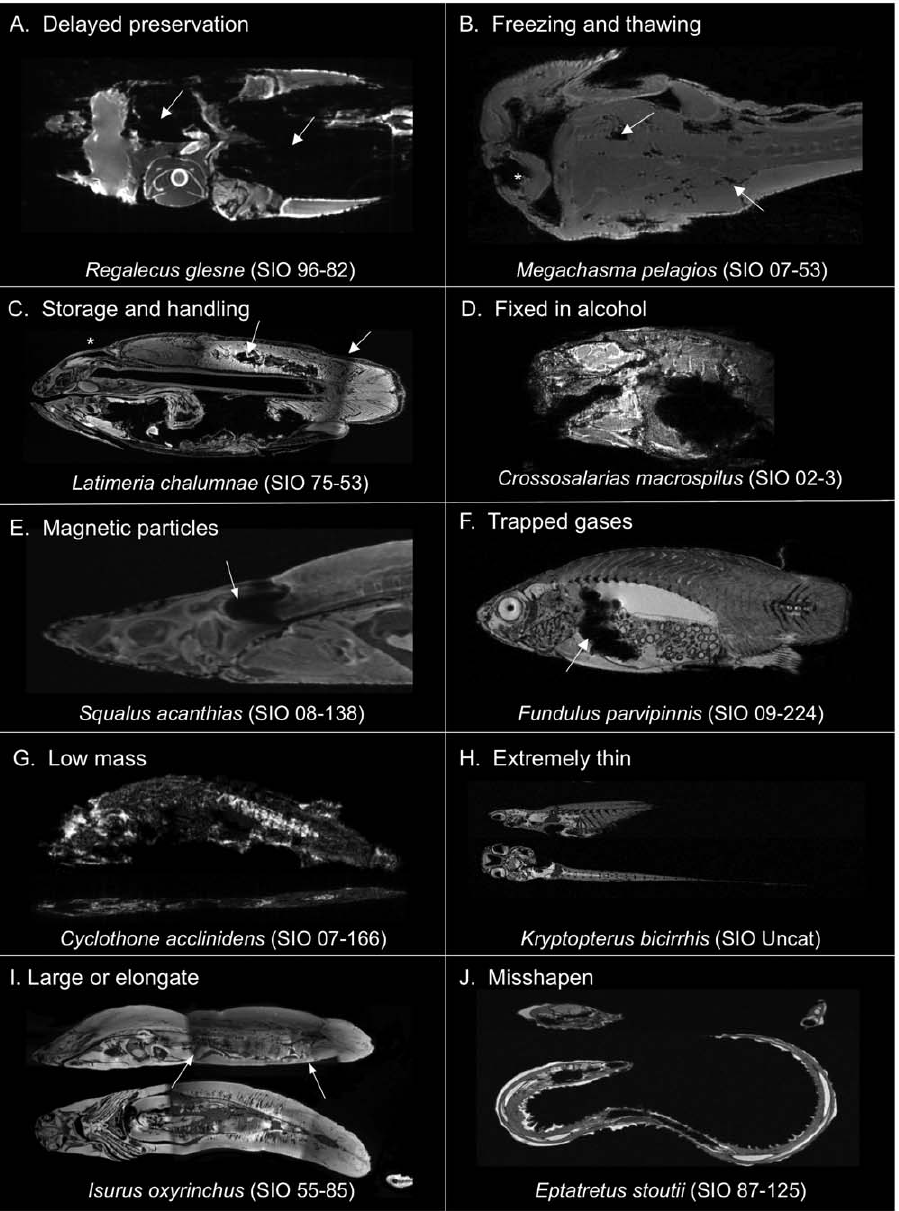
Figure 1. Common problems encountered when scanning museum fishes. Specimens were prepared for imaging and scanned as described in the Methods. Specific details for each species can be found in the DFL. (A) 3T horizontal image slice (937 m m 3 resolution) of an oarfish, Regalecus glesne (SIO 96-82; SL 730 cm) demonstrating the effects of delaying soft tissue preservation. Arrows indicate tissues with significant decomposition. (B) 3T horizontal image slice (1.1 mm 3 resolution) of a megamouth shark, Megachasma pelagios (SIO 07-53; standard length (SL) 215 cm) with significant tissue damage (arrows) from repeated freezing and thawing prior to fixation, resulting in poor tissue MRI signal and contrast. The asterisk indicates mechanical damage to the jaw. (C) 3T sagittal image slice (761 m m 3 resolution) of a coelacanth, Latimeria chalumnae (SIO 75-347; SL 950 mm) demonstrating poor MRI results from being frozen and thawed prior to fixation and from extensive handling including dissection. (D) 7T sagittal slice (100 m m 3 resolution) of a triplespot blenny, Crossosalarias macrospilus (SIO 02-3; SL 73 mm) exhibiting poor imaging results caused by exposure to alcohol without prior formalin fixation. (E) 3T sagittal slice (586 m m 3 resolution) of a spiny dogfish, Squalus acanthias (SIO 08-138; SL 740 mm) showing the presence of inorganic particles in the inner ear causing a prominent magnetic susceptibility artefact. (F) 7T sagittal slice (100 m m 3 resolution) of a California killifish, Fundulus parvipinnis (SIO 09-224; SL 68 mm) exhibiting a prominent magnetic susceptibility artefact caused by gases trapped in its gut. (G) 7T sagittal and horizontal slices (60 m m 3 resolution) of a benttooth bristlemouth, Cyclothone acclinidens (SIO 07-166; SL 53 mm) exhibiting very poor image contrast caused by its extreme low body mass leading to an insufficient signal loading of the RF coil. (H) 7T sagittal and horizontal slices (100 m m 3 resolution) of a glass catfish, Kryptopterus bicirrhis (SIO Uncat; SL 45 mm) showing problems with slice plane misalignment associated with scanning very flat or thin-bodied fishes. (I) 3T sagittal and horizontal slices (586 m m 3 resolution) of a shortfin mako, Isurus oxyrinchus (SIO 55-85; SL 875 mm) showing slice plane misalignment problems associated with scanning large and/or elongate specimens requiring sequential repositioning of the coil to scan their full length. (I) 7T sagittal and horizontal slices (100 m m 3 resolution) of a Pacific hagfish, Eptatretus stoutii (SIO 87-125; SL 145 mm) illustrating slice plane misalignment problems associated with scanning specimens preserved with body positions that cannot be straightened, preventing acquisition of bilaterally symmetrical slices in every plane. doi:10.1371/journal.pone.0034499.g001 PLoS ONE |